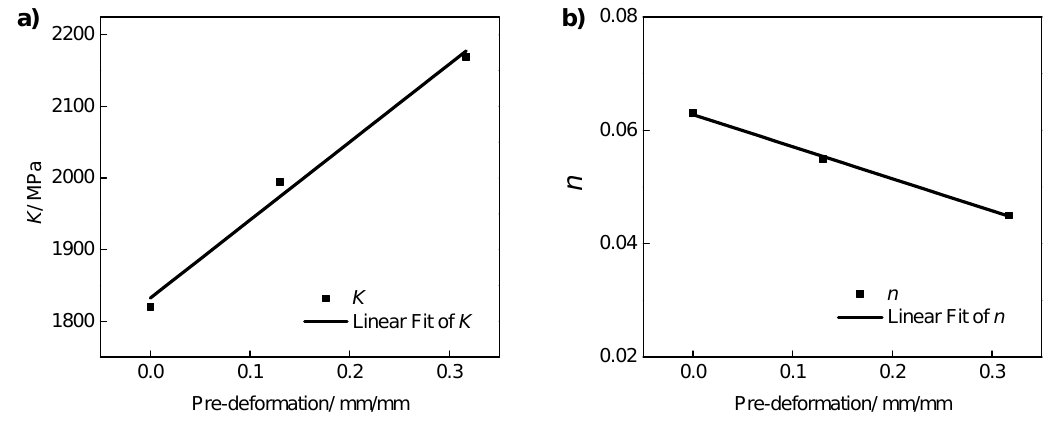
Figure 6. Variation in the mechanical properties with the deformation of pre-deformed IN718. ( a ) The fitted relationship between K and the pre-deformation. ( b ) The fitted relationship between n and the pre-deformation.